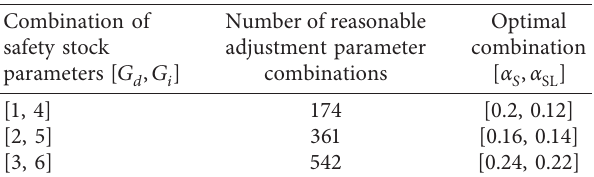
Figure 19: LLE diagram of supply chain nodes under the scenario of random demand obeying uniform distribution from local perspective � 6. (a) The retailer’s LLE chart. (b) The LLE chart of the distribution center. (c) The LLE chart of the combined system when G d � 3 and G 1 from the decision perspective. Table 5: The number and optimal combination of reasonable adjustment parameter combinations under the scenario of random demand obeying uniform distribution from local perspective.